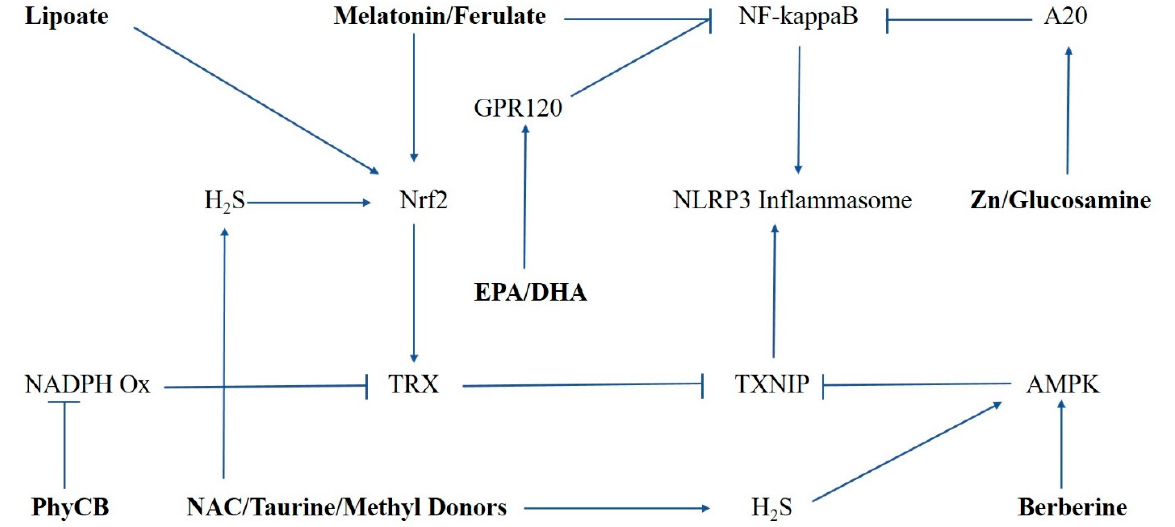
Figure 1. Mechanisms for nutraceutical suppression of NLRP3 inflammasome activation. TRX, thioredoxin; TXNIP, thioredoxin interacting protein.